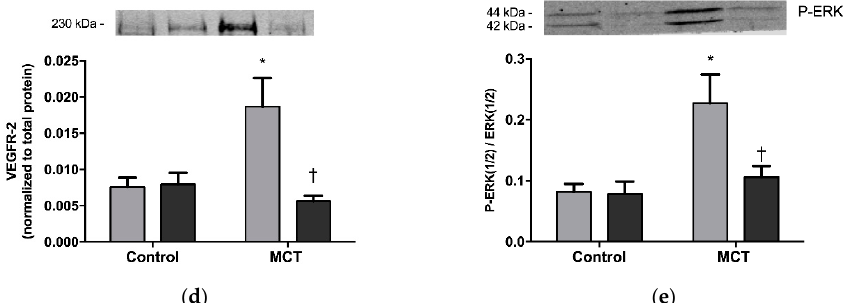
Figure 6. Xanthohumol-fortified beer (FB) improved monocrotaline (MCT)-induced RV remodeling: ( a ) cardiomyocyte cross sectional area, ( b ) fibrosis (demonstrated by the % of collagen deposition), ( d ) VEGFR-2, and ( e ) p-ERK1/2/ERK1/2 ratio. Representative images from CSA and fibrosis from different experimental groups ( c ). Data are mean ± SEM from samples of eight animals per group. * p < 0.05 vs. respective control group, # p < 0.05 vs. Control + SHAM, † p < 0.05 vs. MCT + SHAM. RV: right ventricle, CSA: cross sectional area.